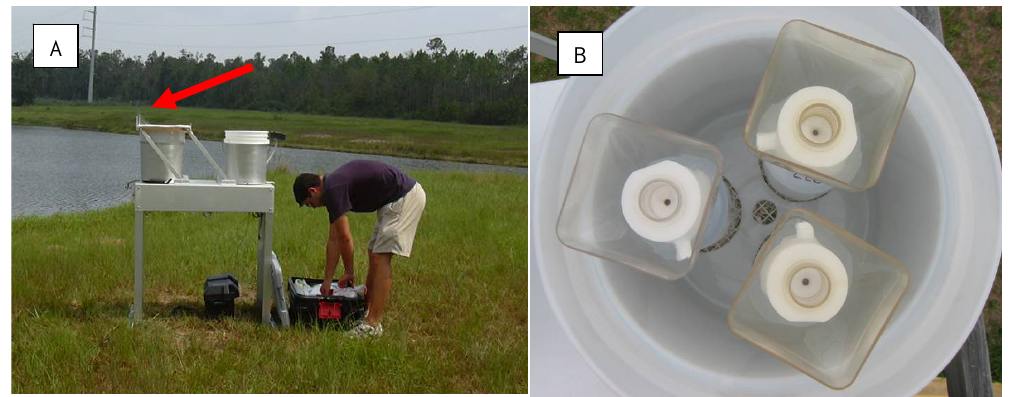
Fig. 2. (A) Automated rainfall collector with a 15cm tall Plexiglas splash guard on the leading edge of the roof to avoid splash contamination during roof retraction (red arrow). (B) Modified receiving bucket with three nested receiving bottles connected to 0.008m 2 polycarbonate funnels using PTFE-Teflon collars.